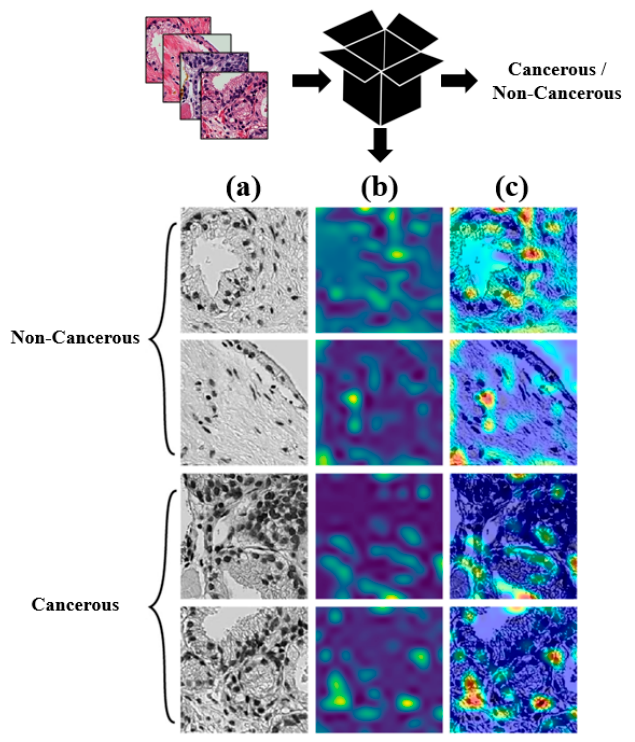
Figure 11. Class activation maps are extracted from one of the classification layers of our convolutional neural network. These show how images are classified and predicted by the neural network, although it is a black-box model. Top and bottom pairs of rows depict benign and malignant tissue images, respectively. ( a ) Input images with an RGB color scheme visualized as grayscale. ( b ) Activation map of classification block, showing detection of different regions in each tissue image. ( c ) Images overlaying ( a , b ), with spots indicating significant regions that the convolutional neural network used to identify a specific in that image.